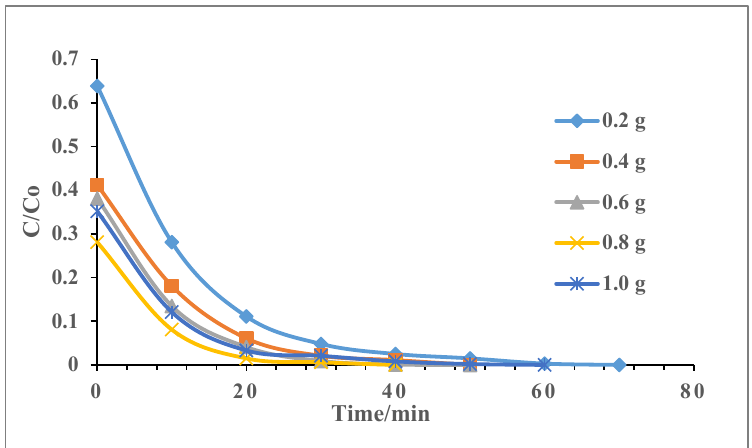
Fig. 9. Effect of amount of FeCr